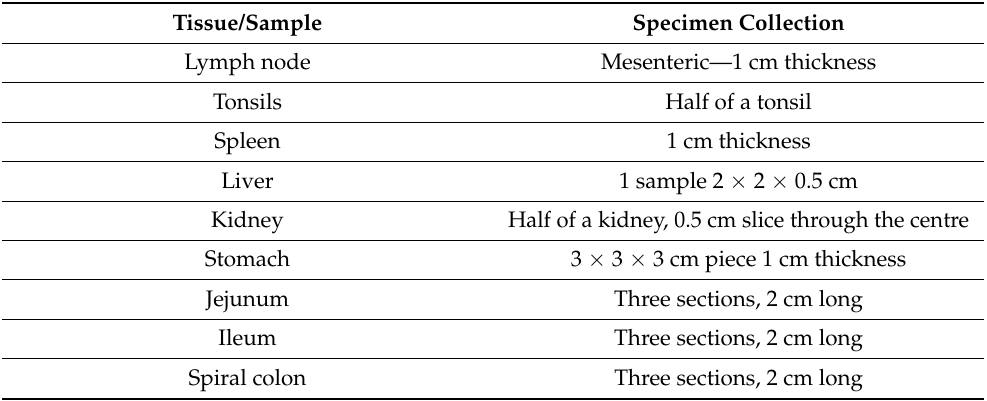
Table 1. Enteric disease: specimen collection for histopathology (Modified from Arruda and Gauger, 2019)